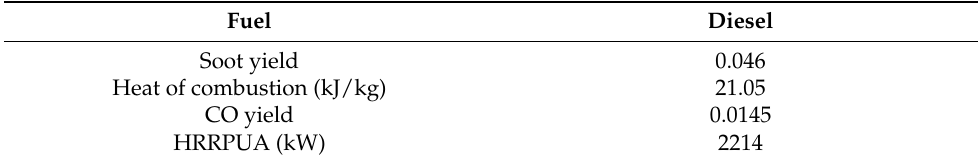
Table 2. Original input parameters for the combustion model.